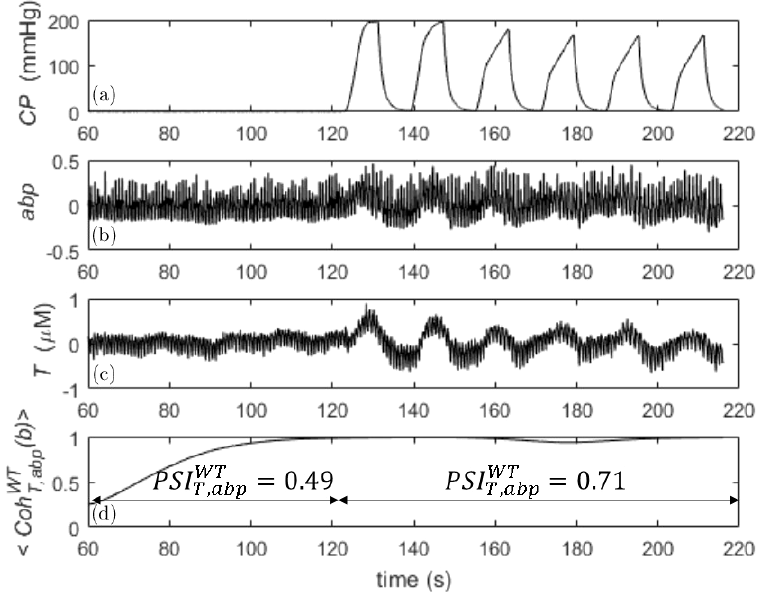
Fig. 1. Raw signals and wavelet coherence between abp and T , calculated on a subject during the ¯rst 2min of baseline (only last 1min is shown) and during the ¯rst group of six cu® oscillations at f cuff ¼ 0 : 0625 Hz. Panel (a) cu® pressure (CP), panel (b) normalized ABP (abp), panel (c) changes in concentration of total hemoglobin ( T Þ , and panel (d) wavelet coherence ðh Coh WT iÞ . In panel (d) are also indicated the values of PSI WT T ; abp T ; abp during baseline and during the group of six cu®